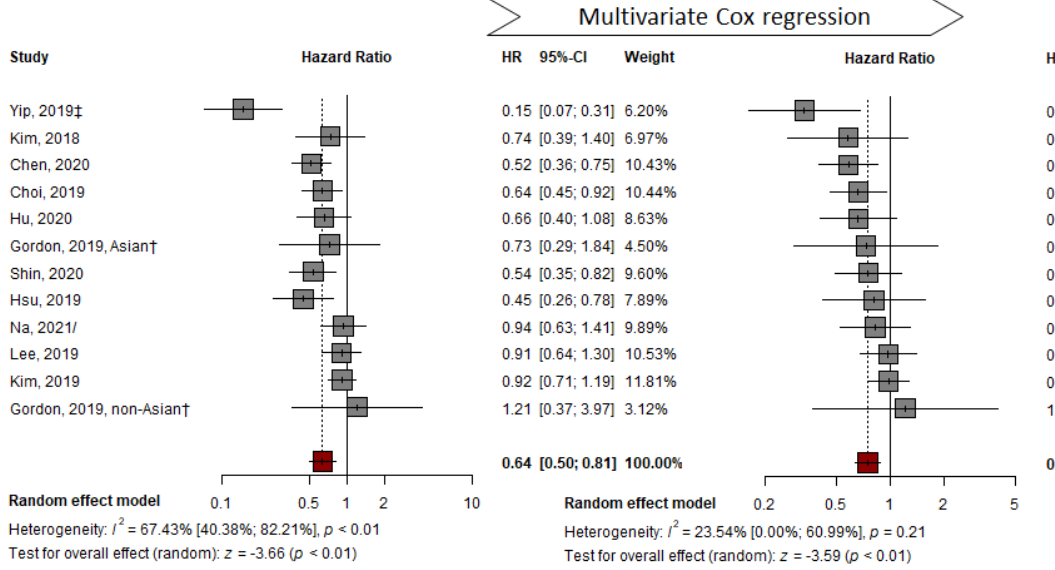
analysis;/from unadjusted cohort at the time of CVR [7,23–27,29,33,38–40].